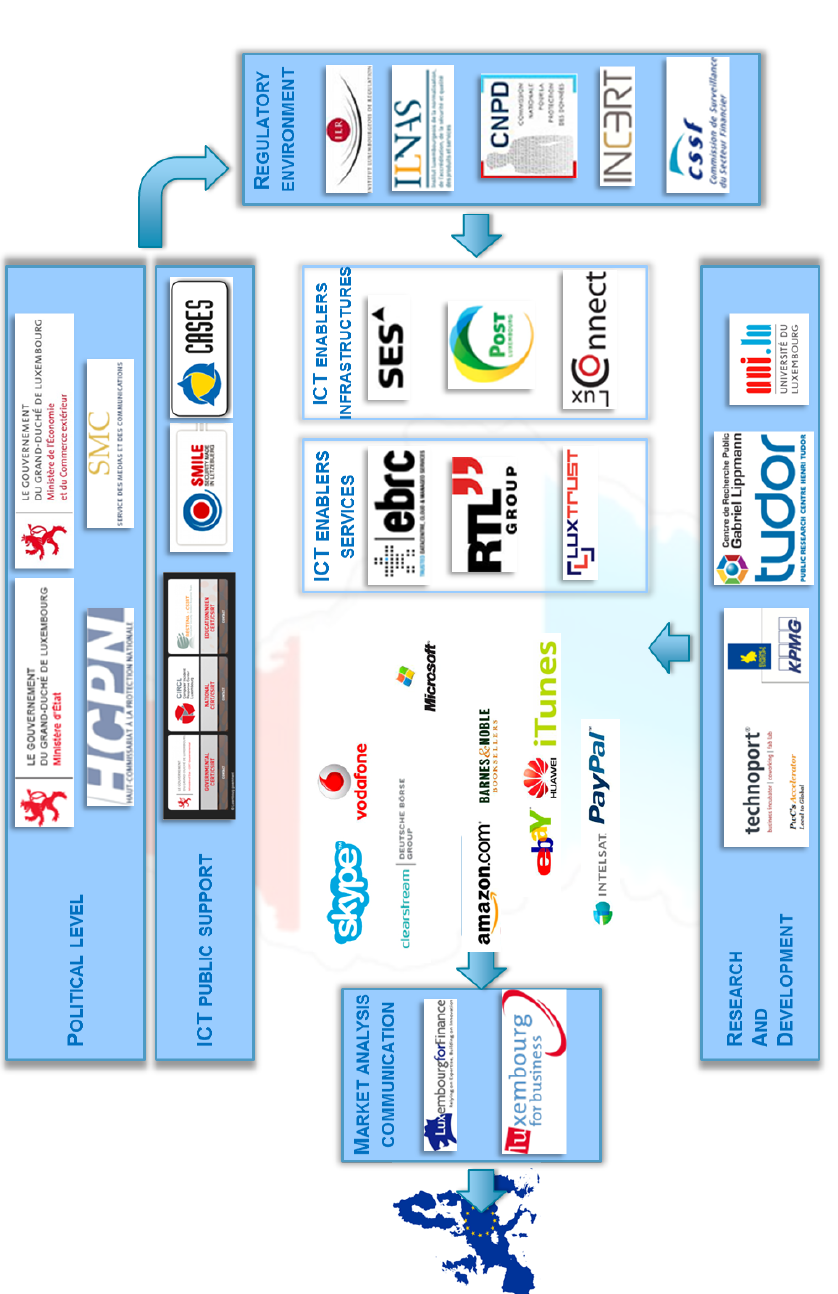
Fig. 3. Luxembourg's ICT Ecosystem (with a subset of major players) 5. Main forces shaping the